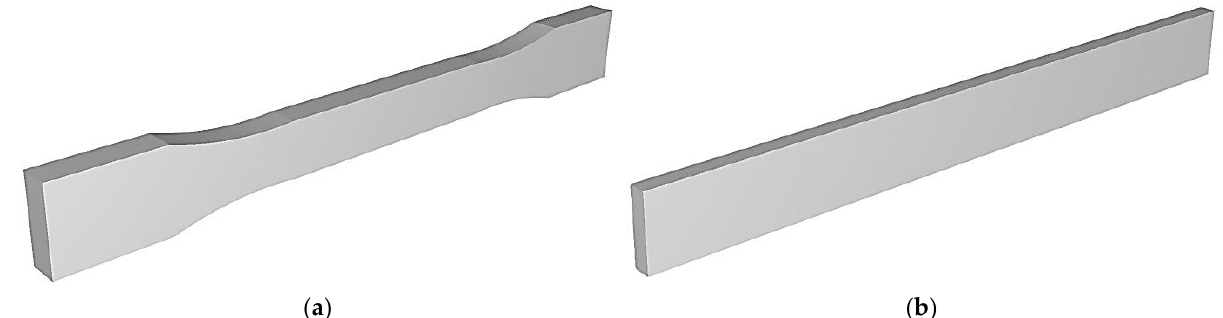
Figure 1. Shapes of composite insulation samples for the ( a ) tensile tests (dog-bone) and ( b ) flexural tests (prism).